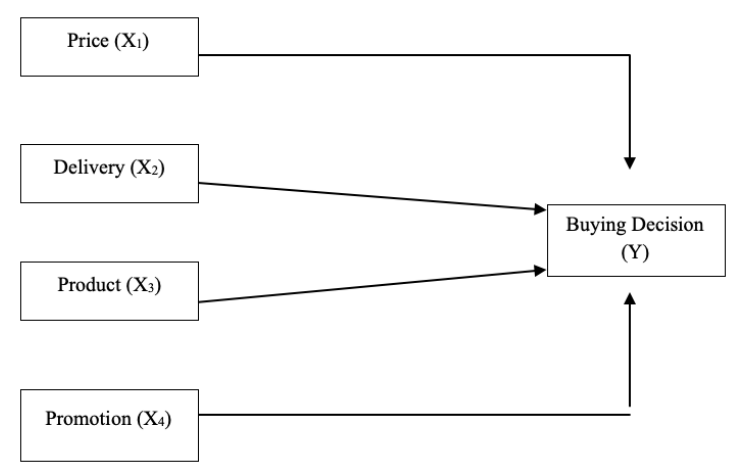
Figure 1: Conceptual Model of The Study; Source: Authors